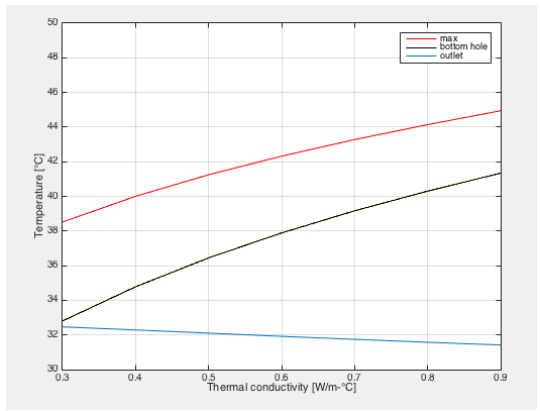
Figure 11: Temperature vs.